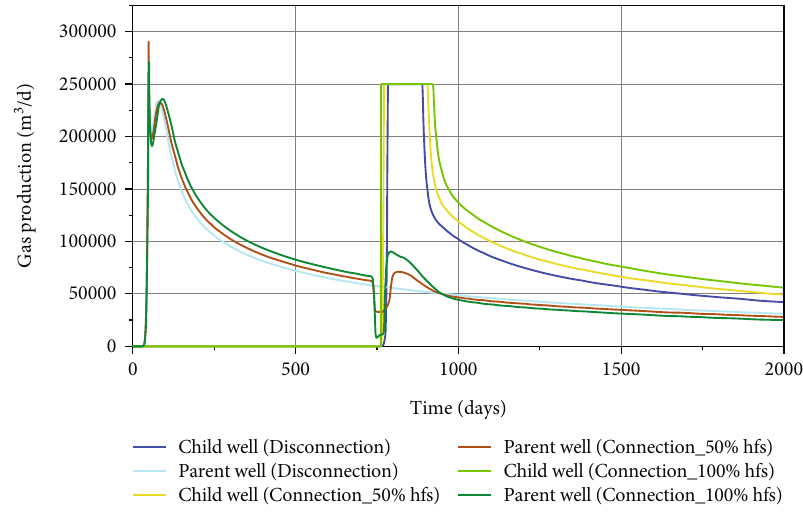
Figure 5: Production curves of two MFHWs considering only hydraulic